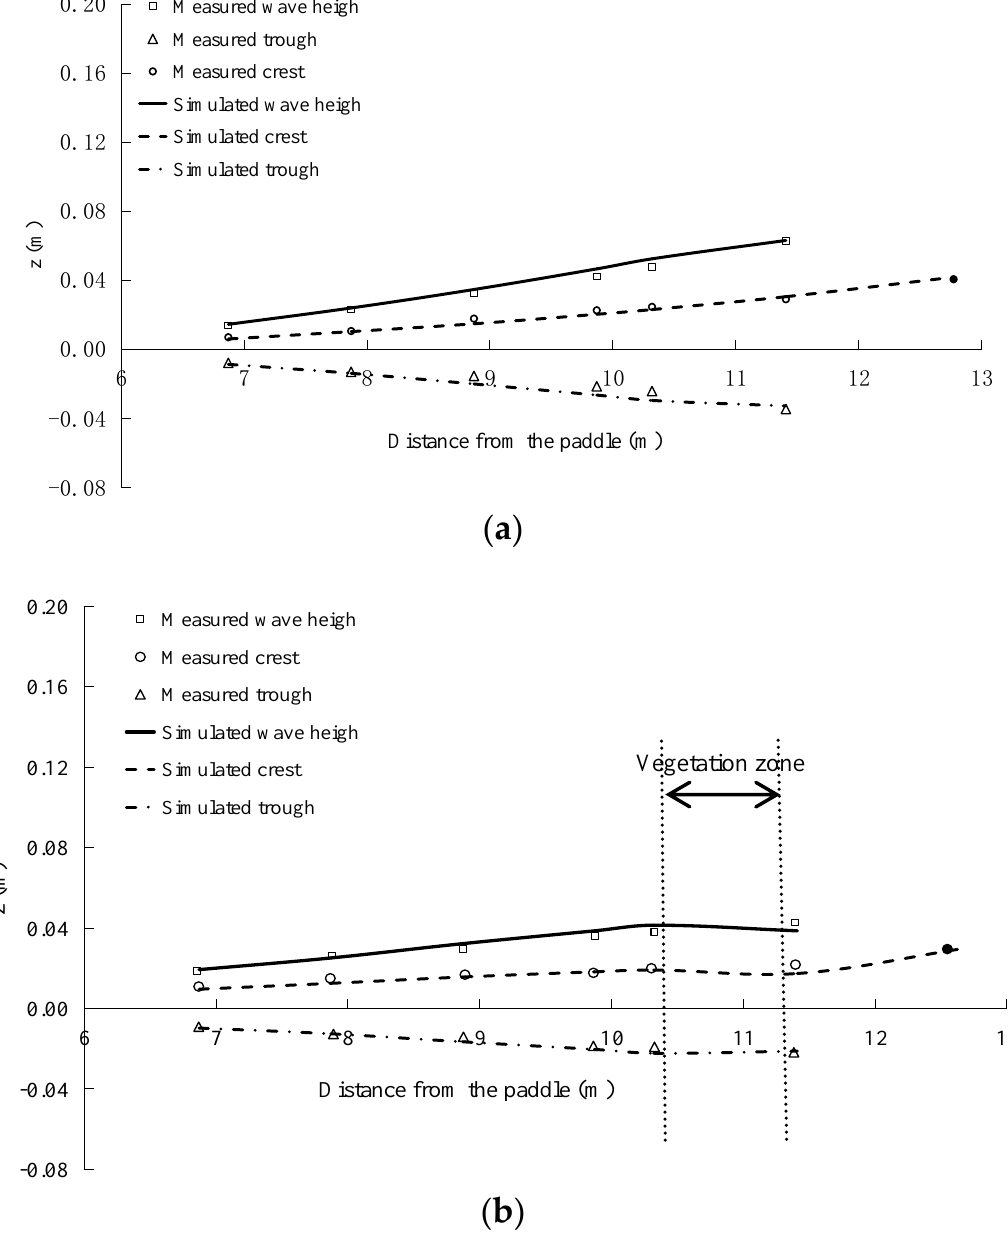
( b ) Figure 7. Time series of velocities, ( a ) at the center of the gap exit, ( b ) at the center of the end of the vegetation.